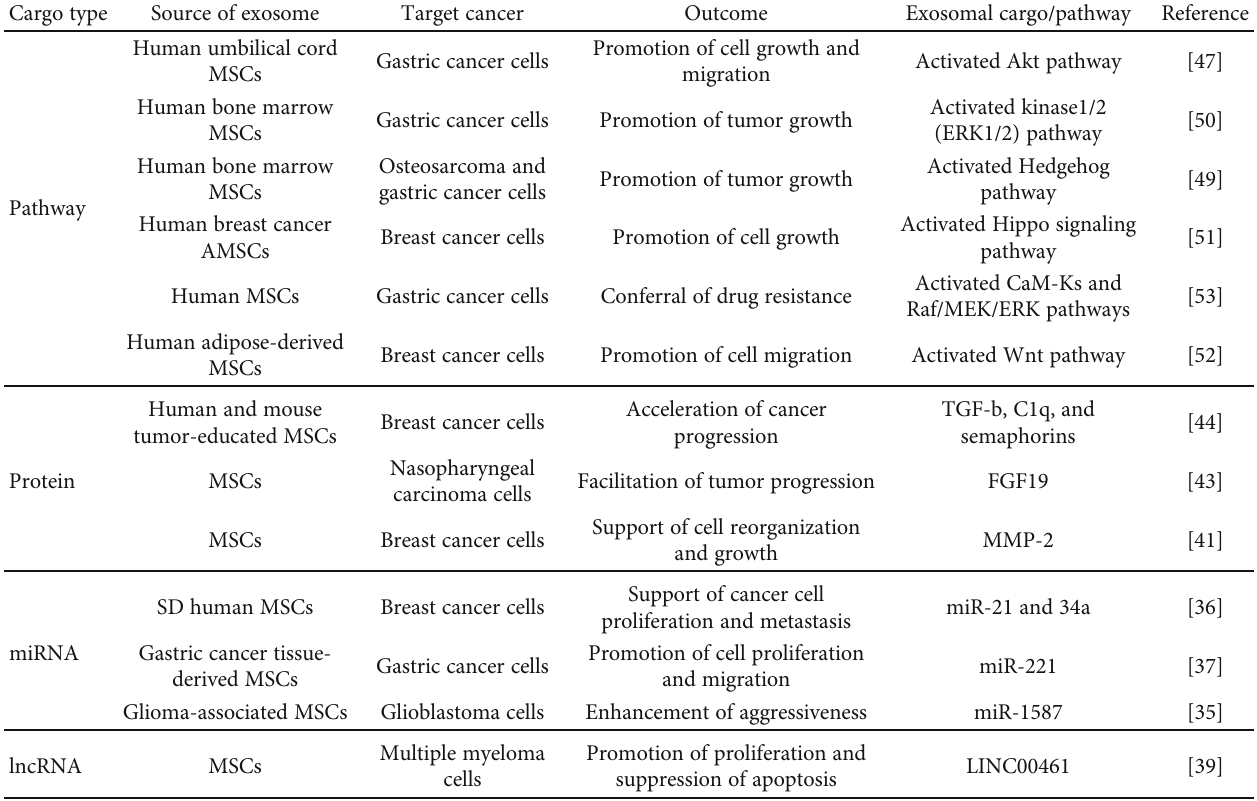
Table 1: Tumor/cancer-promoting cargoes transported by MSC-derived